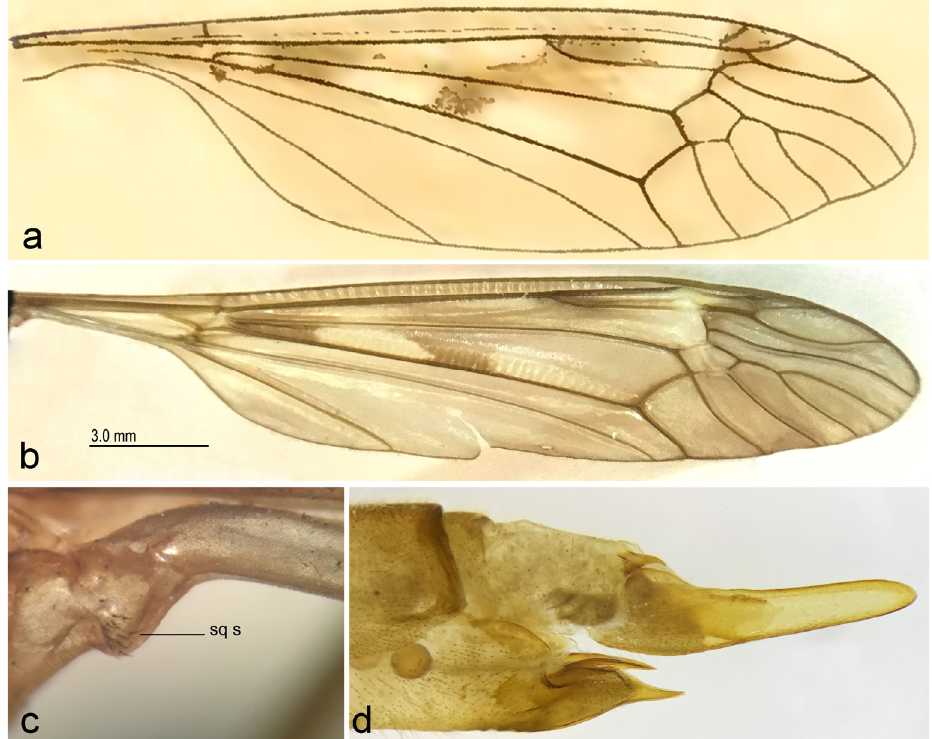
Figure 12. Zelandotipula parviceps (Speiser, 1909); ( a ) Drawing of wing from original description of T. microcephala ; ( b ) Holotype female, right wing; ( c ) idem , setae on squama; ( d ) idem , ovipositor (as in Figure 11c, after maceration in a 4% KOH).